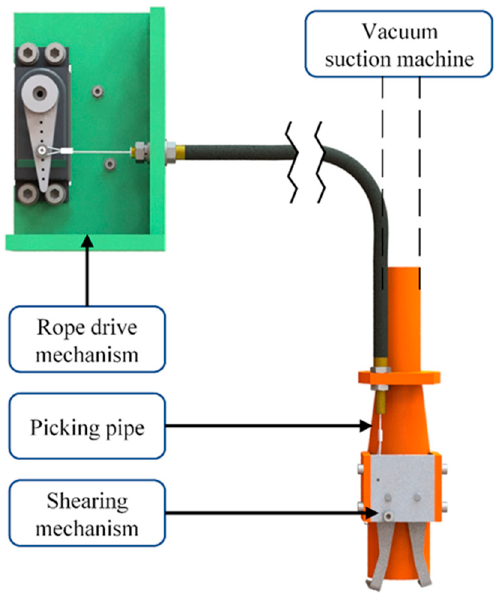
Figure 6. End effector.